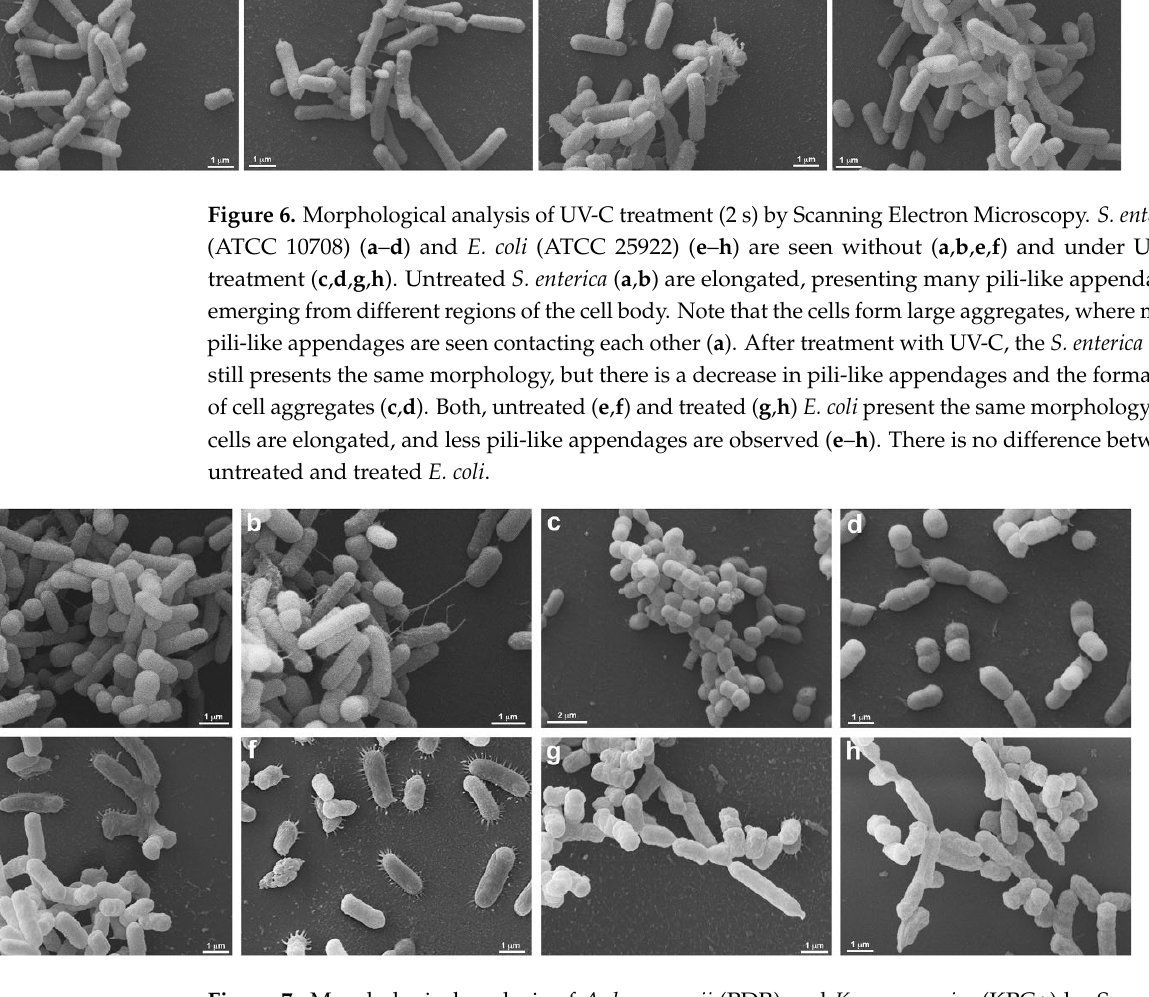
Figure 7. Morphological analysis of A . baumannii (PDR) and K. pneumoniae (KPC+) by Scanning Electron Microscopy. A . baumannii (PDR) ( a – d ) and K. pneumoniae (KPC+) ( e – h ) are seen without ( a , b , e , f ) and under UV-C treatment by 2 s ( c , d , g , h ). Untreated A. baumannii (PDR) ( a , b ) presents a heterogeneous morphology, note the presence of cells with different sizes ( a , b ), some cells present pili-like appendages extending to other bacteria ( b ). After A. baumannii (PDR) treatment ( c , d ), the cell population is homogenously smaller ( c ) when compared with untreated ones ( a ), and no pili-like appendages are seen ( d ). UV-C unexposed K. pneumoniae (KPC+) ( e , f ) present several pili-like appendages around the elongated cell body ( e , f ), these projections are seen mainly when the bacteria are adhered to the substrate ( f ). In treated K. pneumoniae (KPC+) ( g , h ) it is possible to note that the cell surface is wrinkled ( g , h ), there are different cell sizes ( g ) and there are no pili-like appendages ( g , h